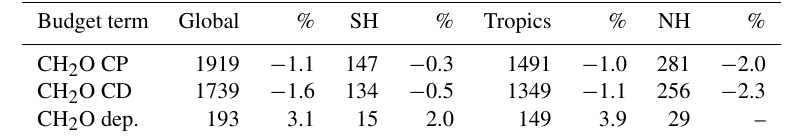
Table 8. The tropospheric chemical budget for the CH 2 O given in TgCH 2 Oyr − 1 during 2006 for the 1 ◦ × 1 ◦ simulation. Percentage differences are shown against the corresponding 3 ◦ × 2 ◦ simulation.